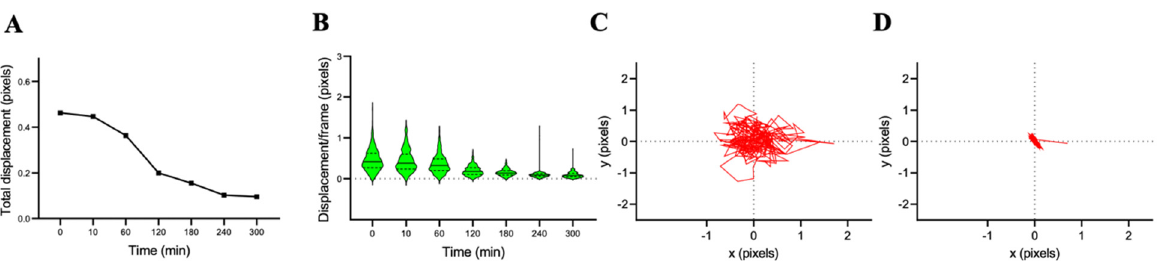
Figure 16. Effect of the antifungal fluconazole (1 µ g/mL) on the cellular nanomotion of cell 1 from C. albicans DSY1024. ( A ) Total displacement (pixels) as a function of time for cell 1 ( B ) Distribution of the displacement/frame as a function of time for cell 1. ( C ) X − y displacement of cell 1 before treatment time point 0 min. ( D ) X − y displacement of cell 1 after 300 min of treatment.